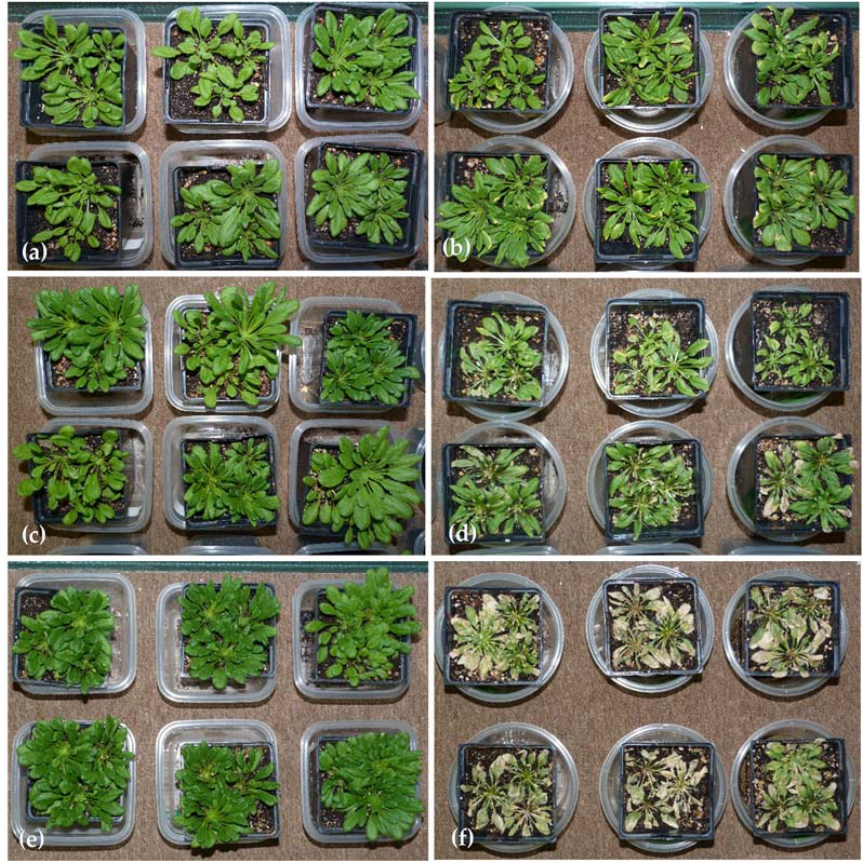
Figure 4. Example ( a ) B. napus and ( b ) H. annuus plants at week 3. Arrows in ( a ) are pointing out areas